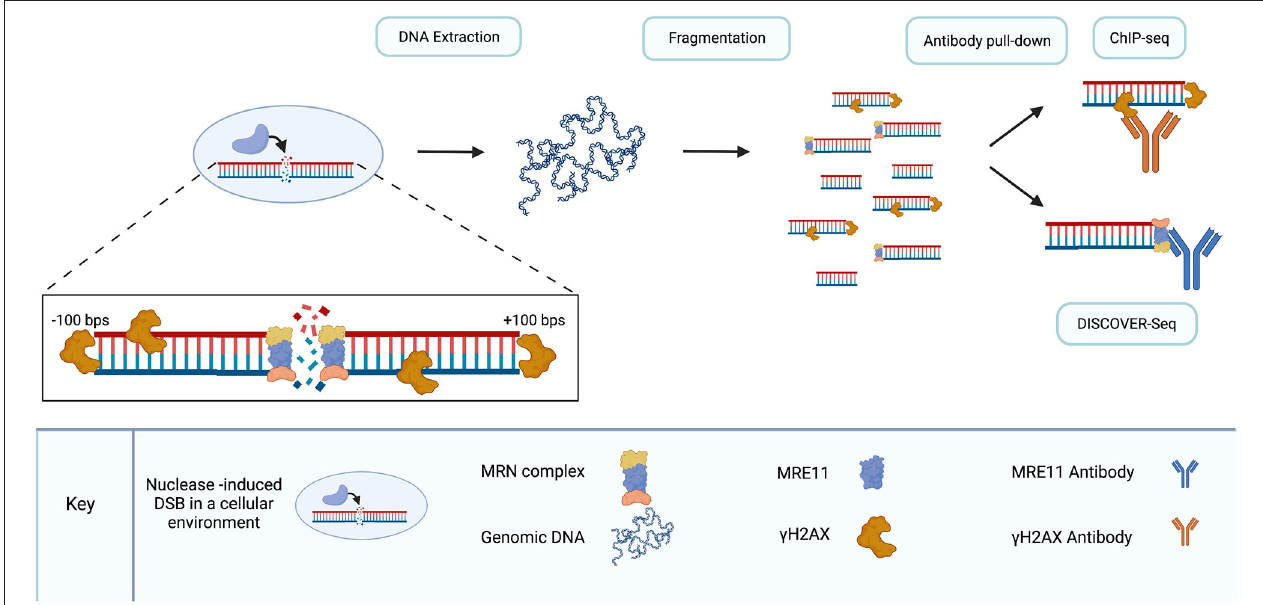
FIGURE 5 | DISCOVER-seq is a specialized version of ChIP-seq. As DSBs are introduced to DNA in living cells, endogenous repair processes recruit proteins to break sites. γ H2AX localizes to DSBs within hundreds of base pairs in either direction. The MRN complex, recruited by γ H2AX, localizes to the break site. Following genomic DNA extraction and fragmentation, antibody pull-down of fragments enables the sequencing of fragments surrounding DSBs. γ H2AX pull-down is used in ChIP-seq and lacks the resolution to precisely locate DSB sites. MRN pull-down, specifically the MRE11 subunit of the MRN complex, enables precise sequencing of DSB sites with single-nucleotide resolution. Use of the MRE11 antibody for pull-down is the distinguishing characteristic of DISCOVER-seq compared to ChIP-seq. Created with